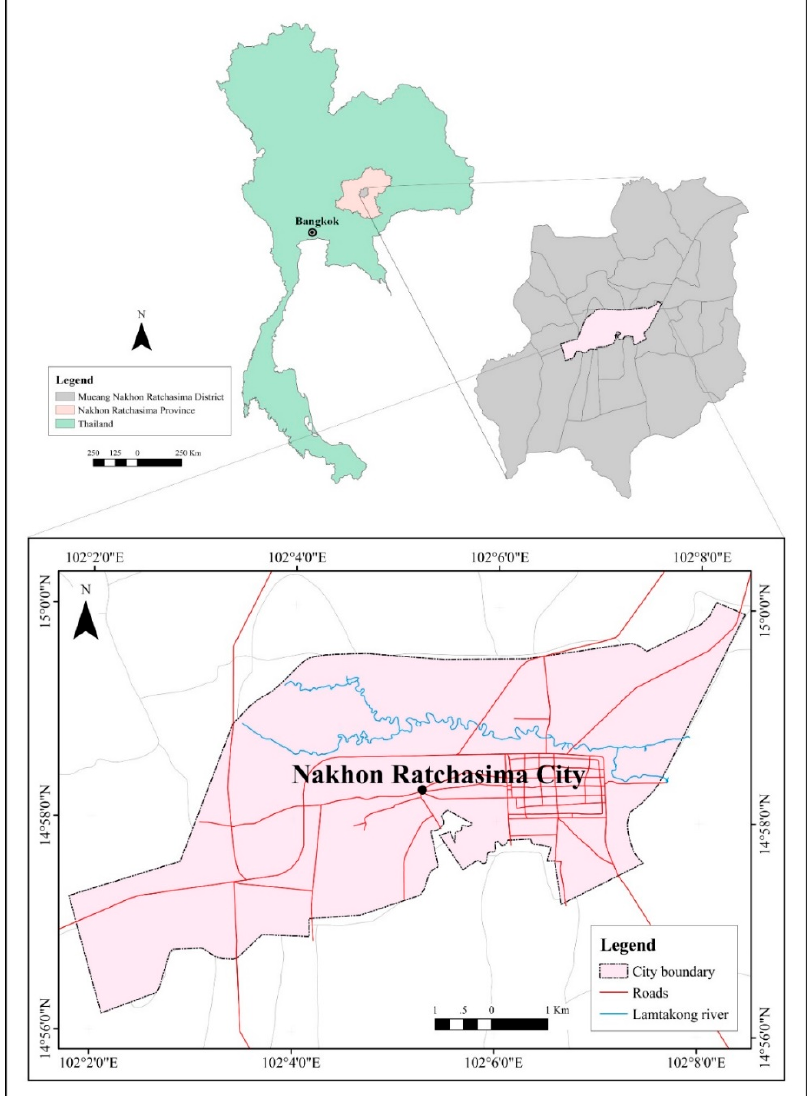
Figure 1. Nakhon Ratchasima City.